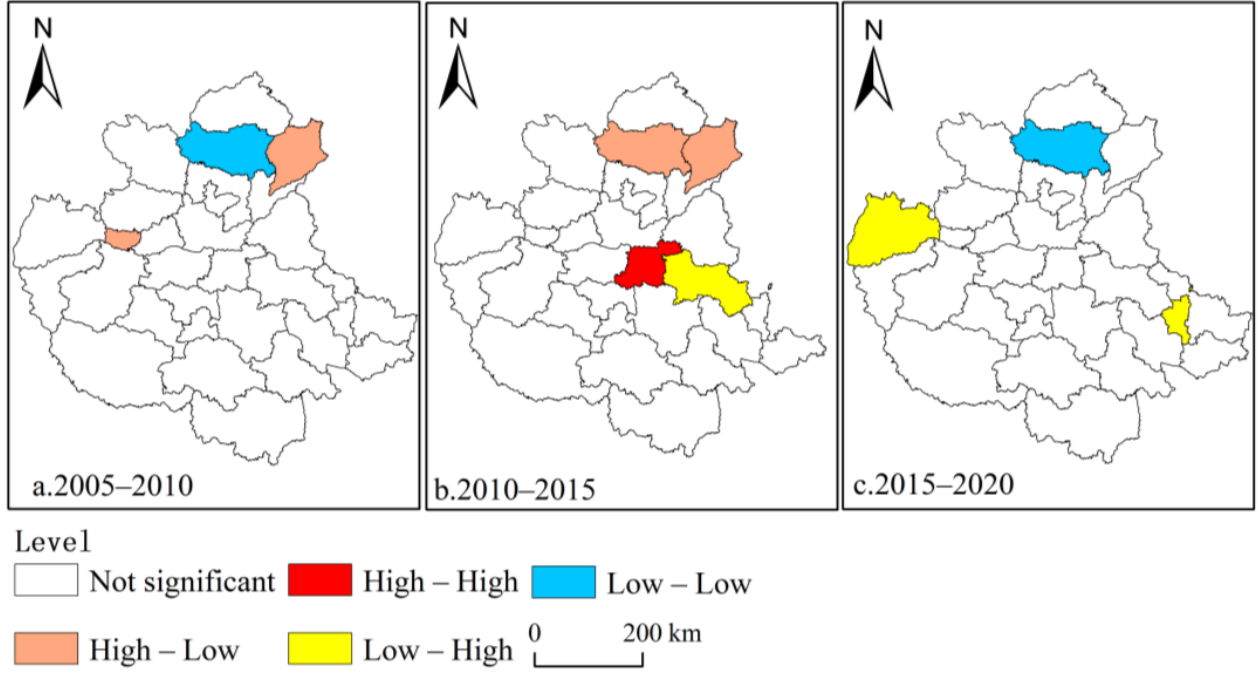
Figure 7. Spatial correlation between urban expansion and economic growth. ( a ) 2005–2010 Local bivariate spatial autocorrelation; ( b ) 2010–2015 Local bivariate spatial autocorrelation; ( c ) 2015–2020 Local bivariate spatial autocorrelation.